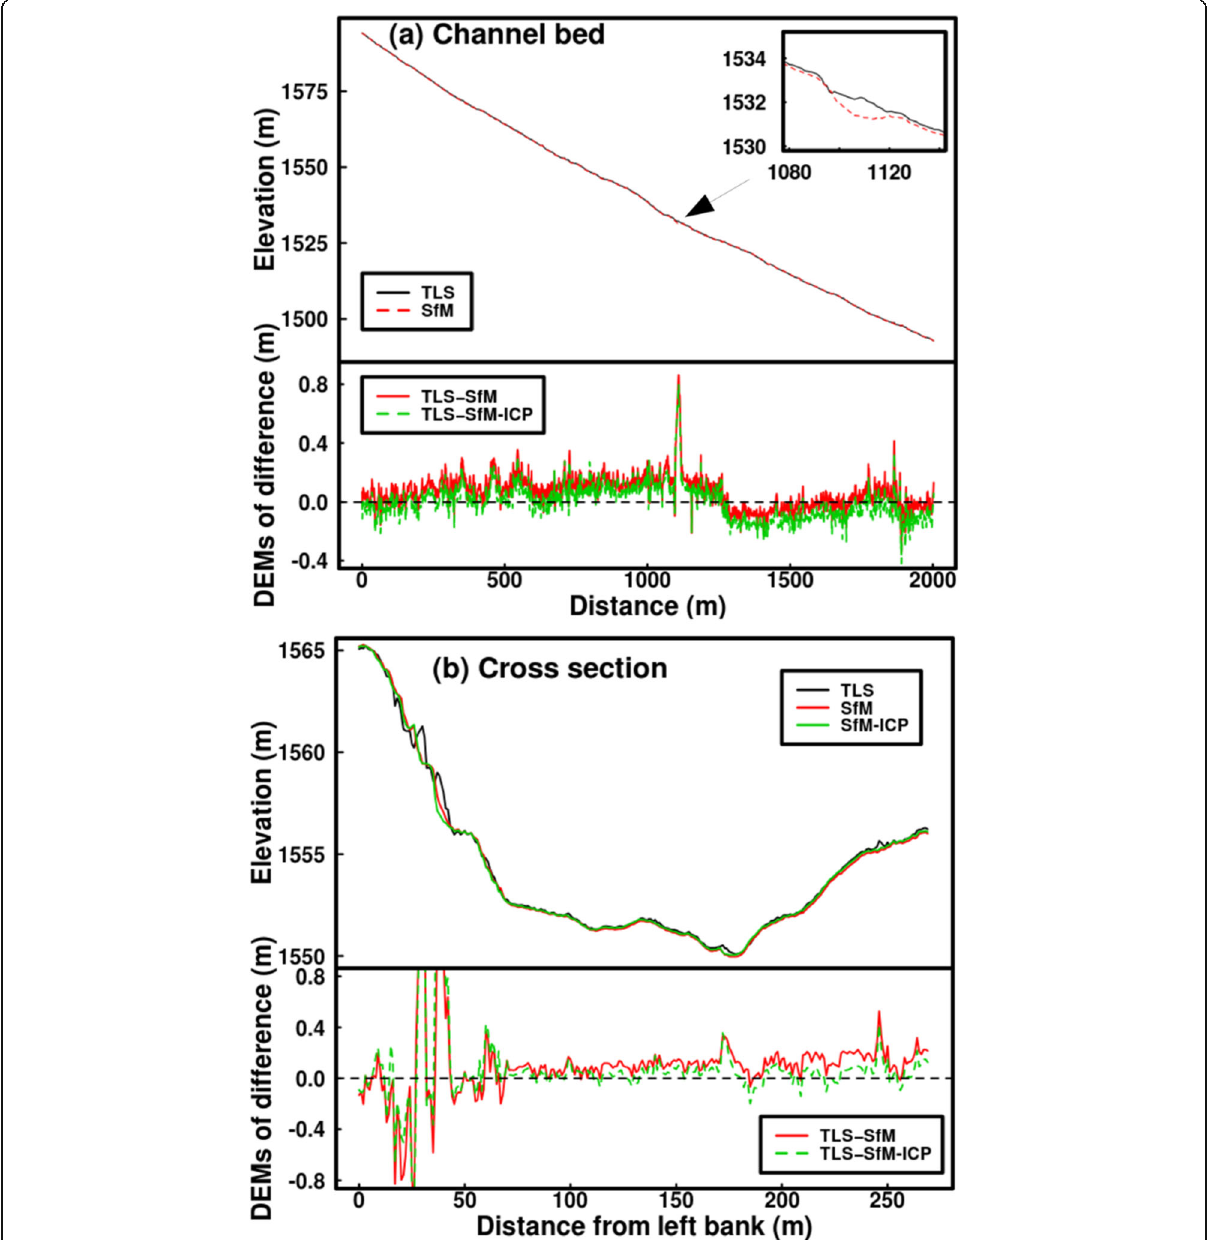
Fig. 7 Comparison of the elevation and DoDs along ( a ) a profile of the channel bed and ( b ) a cross section through the channel, as indicated in Fig. 1. The inset of ( a ) indicates the topical depressions of channel